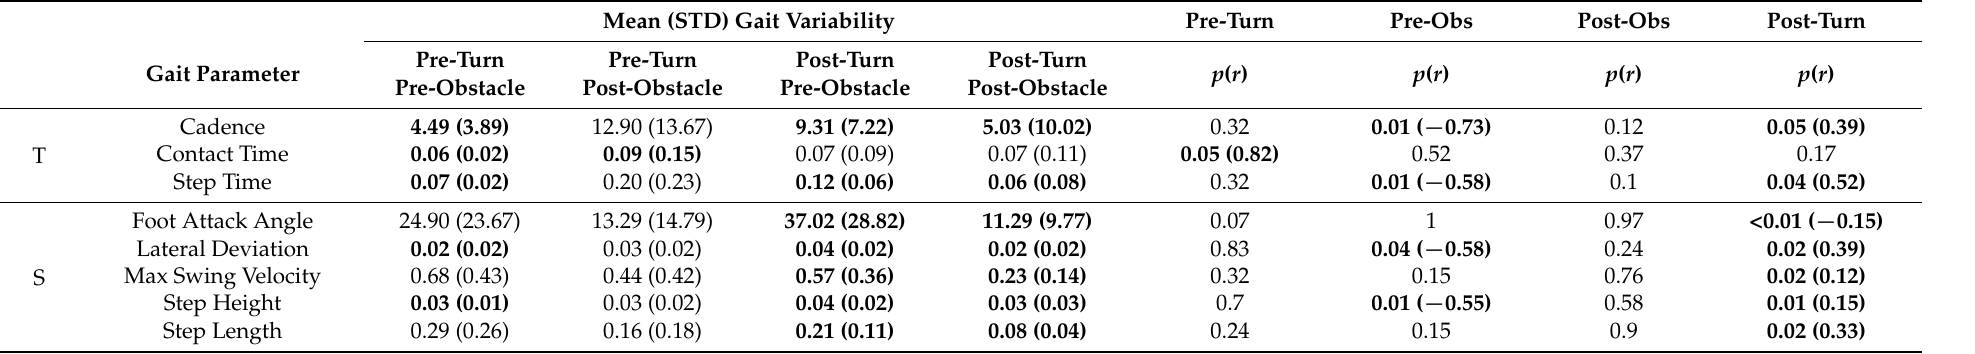
Table 5. Comparisons of gait variability during phases of the walk and turn with obstacle task for controls. p -values ( p ) are reported for each comparison with effect sizes ( r ) indicated for significant differences. Comparisons: Pre-turn pre-obstacle to pre-turn post obstacle (pre-turn), pre-turn pre-obstacle to post-turn pre-obstacle (pre-obs), pre-turn post-obstacle to post-turn post-obstacle (post-obs), and post-turn pre-obstacle to post-turn post-obstacle